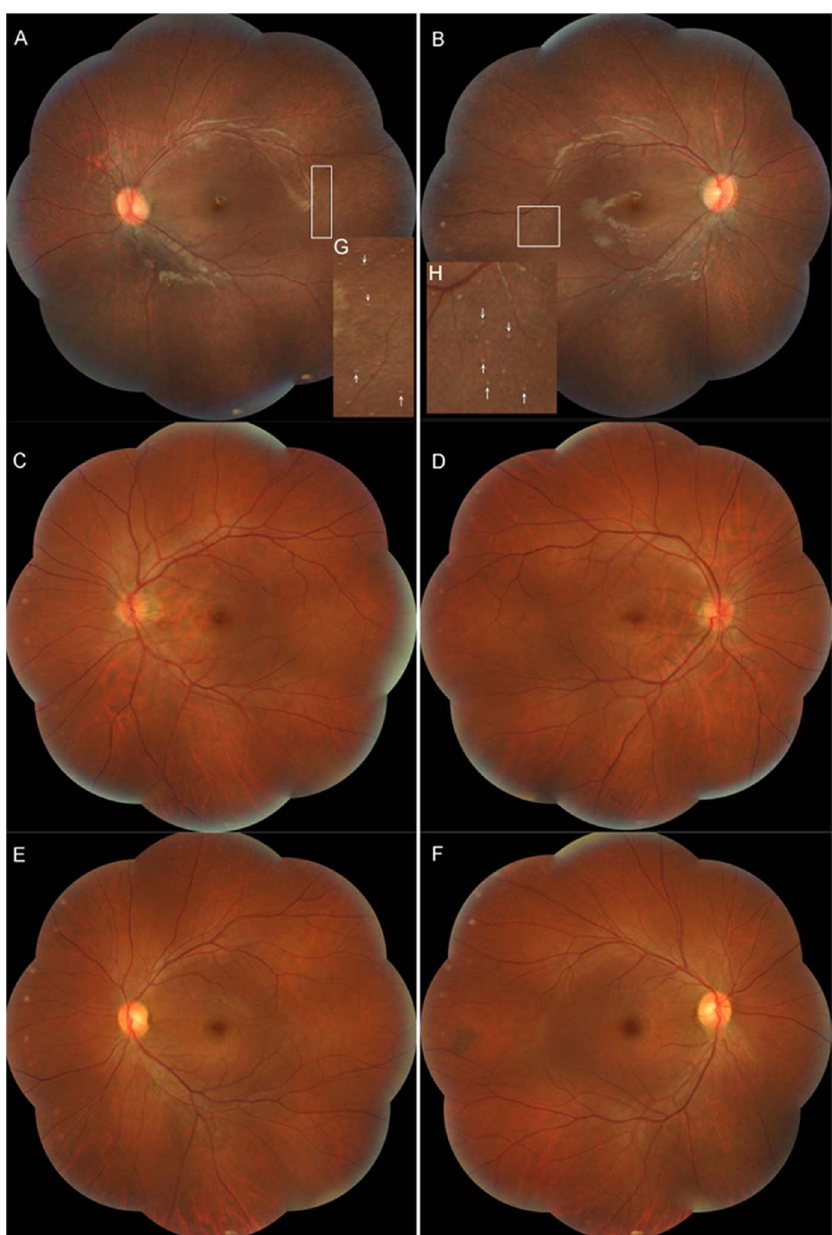
Figure 2. Fundus photographs of both eyes in the family. Color fundus photographs of both eyes (a: left eye; b: right eye) show mildly attenuated retinal vessels, some whitish dots, and numerous grayish deposits in the mid-peripheral retina of the patient. The inserted panels (g, h) show a magnification of the indicated areas. Whitish dots are marked by white arrowheads. Fundus photographs of her father (c, d) and her mother (e, f) show no whitish dots or grayish deposits in the mid-peripheral retina. doi:10.1371/journal.pone.0112400.g002 layer, RPE-choroid and ISe-choroid,and the results were 239 m m (Figure 3c-2, 3d-2, 3e-2, and 3f-2). The aforementioned abnor- (Figure 3g-2), 24 m m (Figure 3g-3), and ISe-choroid (Figure 3g-4), malities were not presented in her parents’ grayscale foveal SD- respectively. OCT recordings (Figure 3 c-2, 3d-2, 3e-2, and 3f-2). Meanwhile, we also measured the thinkness of ISe, RPE, and RPE-choroid of the patient and her parents’s right eyes (Figure 3g, 3h, and 3i). Her father/mother’ results were 15 m m/15 m m (Figure 3h-2 and 3i-2), 16 m m/16 m m (Figure 3h-3 and 3i-3), and 40 m m/35 m m (Fig- ure 3h-4 and 3i-4). Because the boundaries of IS, ISe, OS, and RPE are not clear, we cannot measure the thickness of ISe and RPE. Therefore, we measured the noncontiguous area of ISe Table 2. All four mutations were present in the heterozygous state.